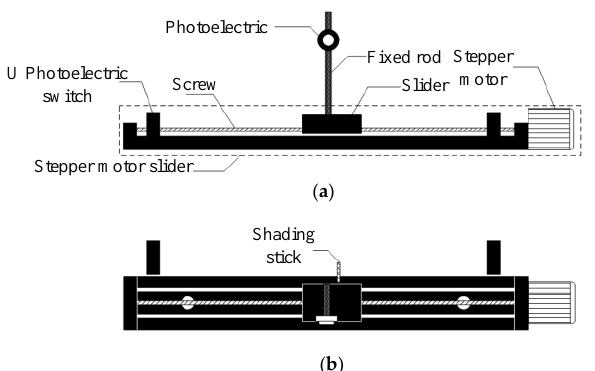
Figure 8. Incident light intensity detection structure diagram: ( a ) front view; and, ( b ) top view.